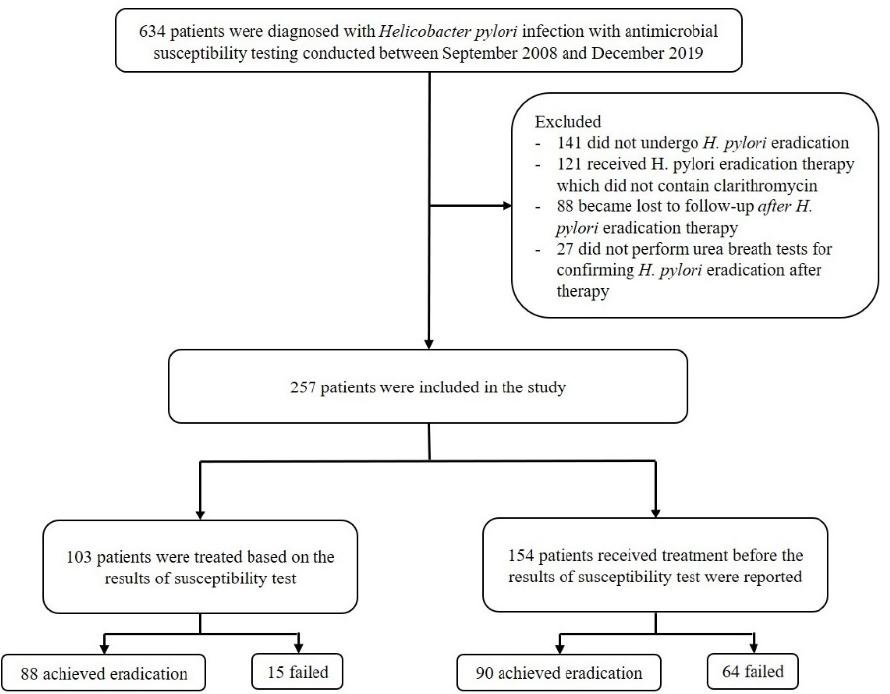
Figure 1. Flowchart of the process of patient enrollment.